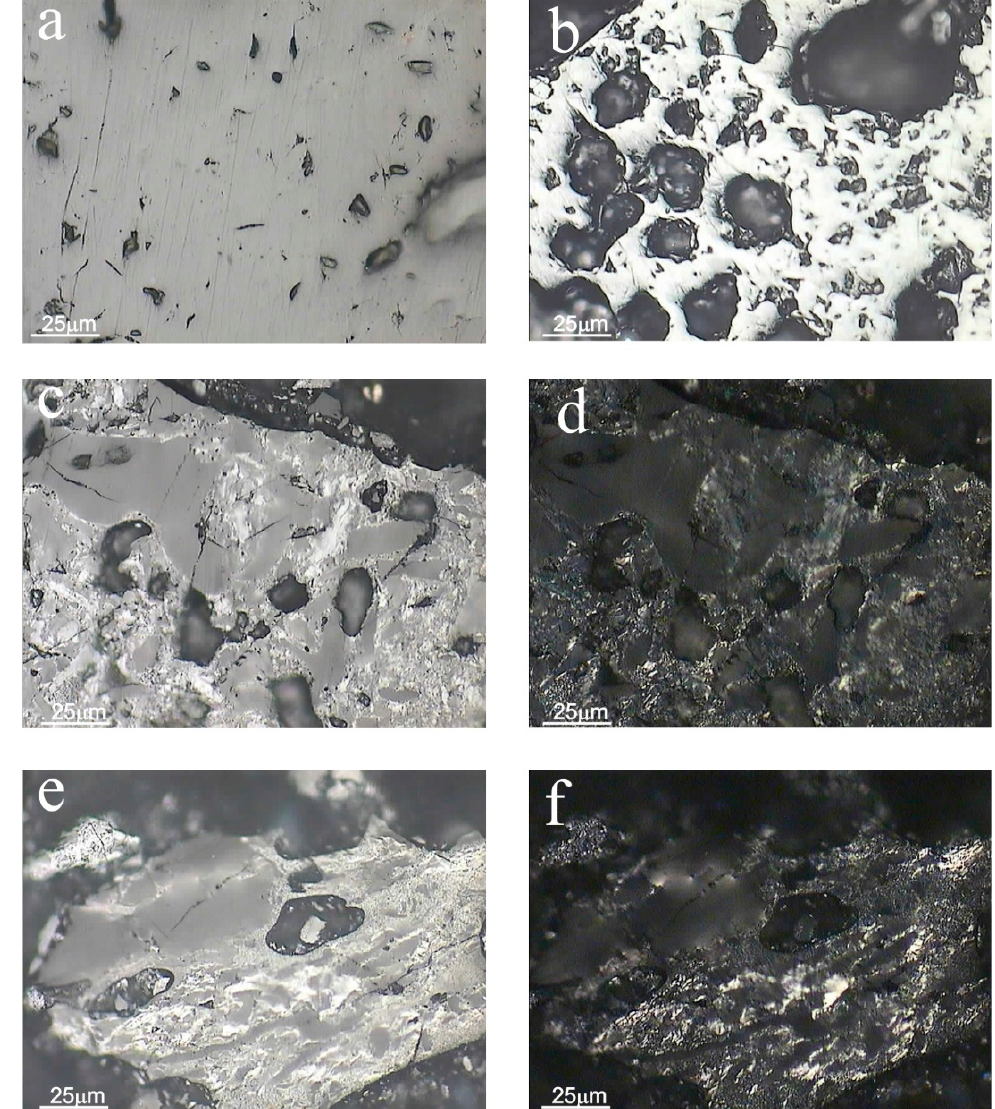
Figure 8. The residue after gasification of coal at a pressure of 10 bar. ( a ) Vitrinite with pores after degassing is visible; ( b ) heat-altered coal–coke structure is visible; ( c ) heat-altered coal–mesophase is visible (parallel nicols); ( d ) the same field as photo c (crossed nicols); ( e ) heat-altered coal–mesophase and thermally-altered liptinite is visible (parallel nicols); ( f ) the same field as photo e–(crossed nicols). reactor chamber inlet, the values of the true maximum reflectance and bireflectance